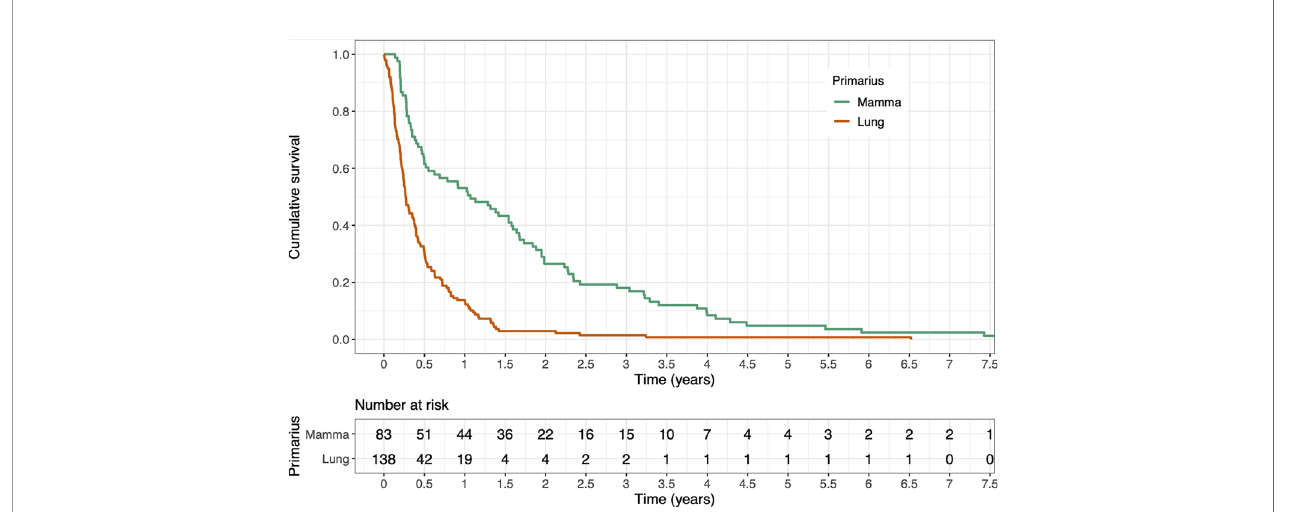
FIGURE 2 | Kaplan-Meier estimate of overall survival after fi rst radiotherapy strati fi ed by tumor histology. OS was signi fi cantly better for breast cancer patients compared to lung cancer patients (p < 0.001, log-rank test).